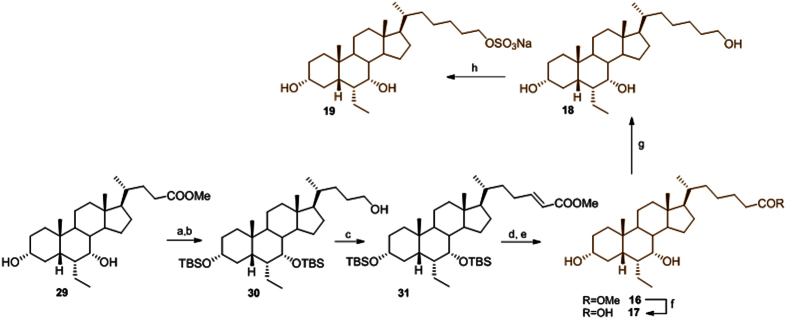
Preparation of bis-homo 6-ethylcholane derivatives.Reagents and conditions: (a) 2,6-lutidine, t-butyldimethylsilyl trifluoromethanesulfonate, CH2Cl2, 0 °C; (b) LiBH4, MeOH dry, THF, 0 °C, 68% over two steps; (c) DMSO, oxalyl chloride, TEA dry, CH2Cl2, −78 °C then methyl(triphenylphosphoranylidene)acetate, 79%; (d) H2, Pd(OH)2/C Degussa type, THF/MeOH 1:1, quantitative yield; (e) HCl 37%, MeOH, 88%; (f) NaOH 5% in MeOH/H2O 1:1 v/v, 89%; (g) LiBH4, MeOH dry, THF, 0 °C, 78%; (h) Et3N.SO3, DMF, 95 °C, 25%.